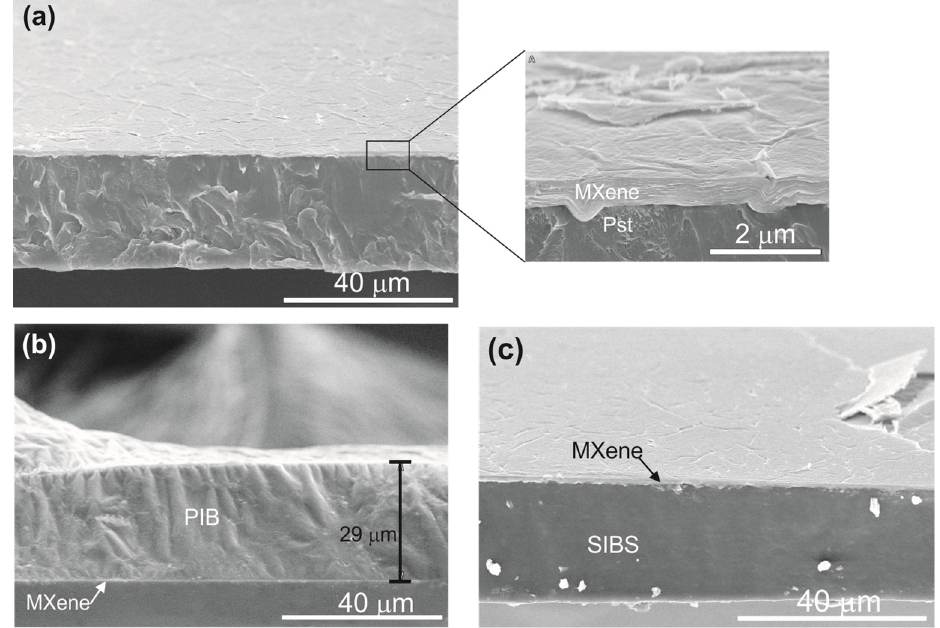
Figure 5. SEM images of MXene–polymer interface: ( а )—MXene-PSt, ( b )—MXene-PIB, ( c )—MXene-SIBS.